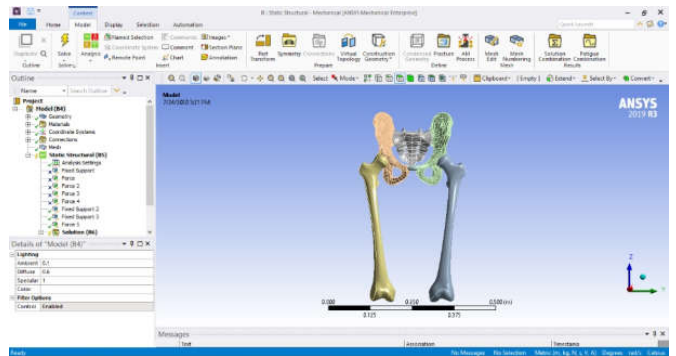
Figure 33. Ansys Workbench software interface after loading the normal human hip joint model.